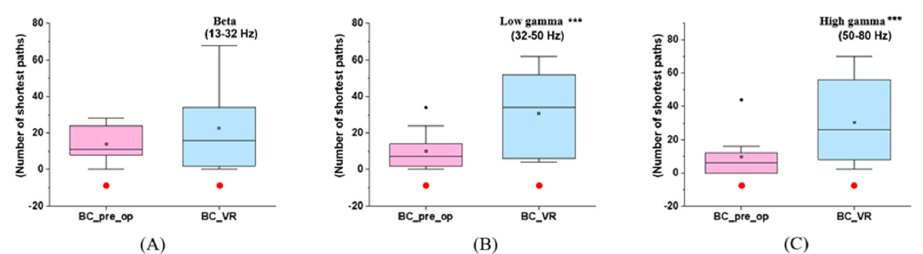
Figure 5. BC variations of a lateralized occipital channel (O1 or O2) in stages one and three at different frequency bands: ( A ) BC in the beta band ( p = 0.33); ( B ) BC in the low gamma band ( p = 0.01); ( C ) BC in the high gamma band ( p = 0.008). *** indicates that the difference in the diagram is significant ( p < 0.05) in the paired–samples t –test. The solid red circle indicates no gender difference for this parameter in this stage.